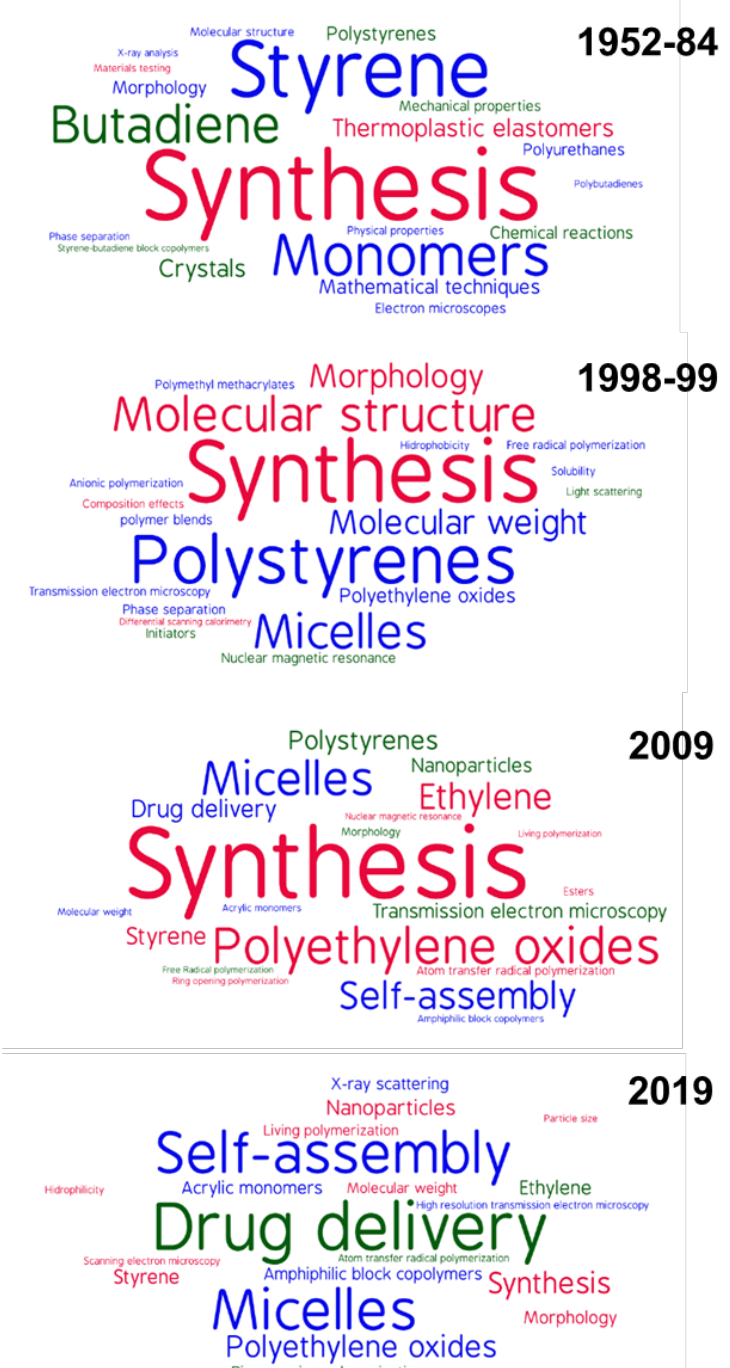
Figure 10. Word clouds of author keywords and their associations in publications on block copolymers, in 1952 – 1984, 1998 – 1999, 2009, and 2019. Every word cloud considers the top 20 keywords of the period, with sizes directly proportional to the number of publications.